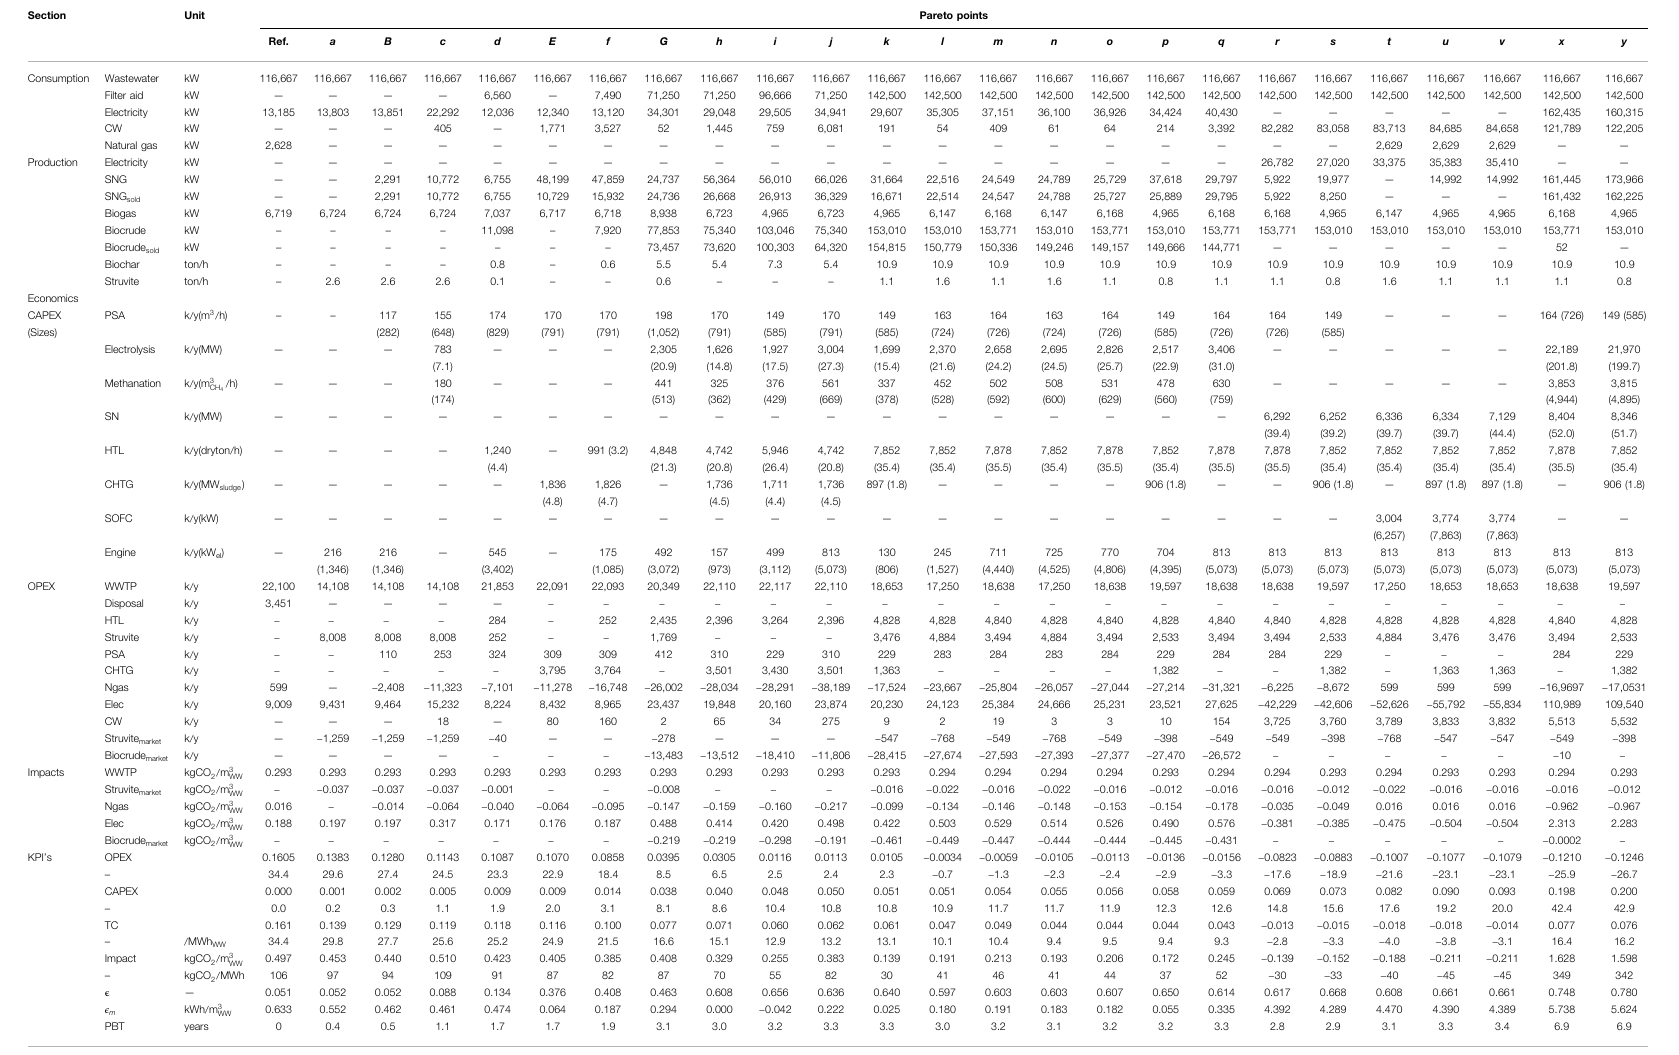
TABLE 7 | Detailed energy, costs, sizes, and KPIs for Pareto points. Section